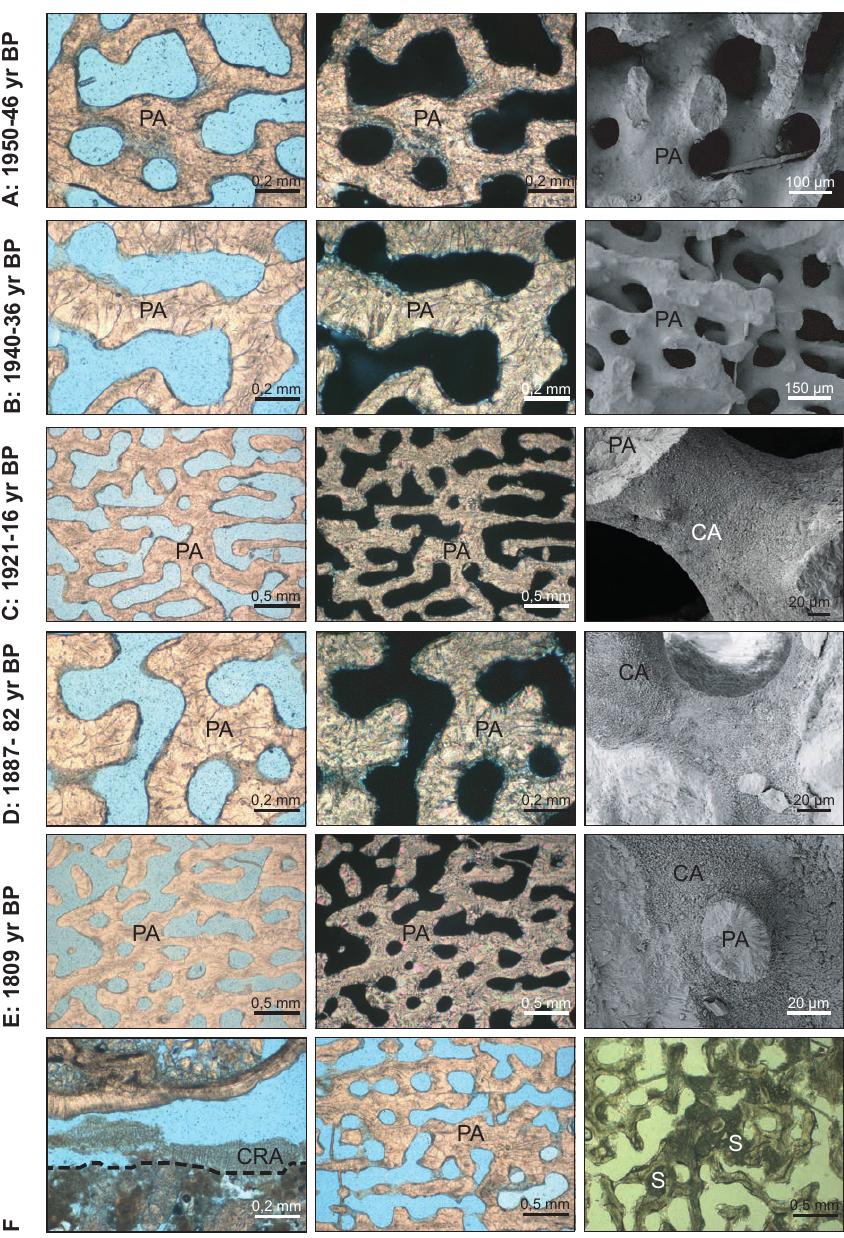
Figure 3. Thin-section and SEM images of primary coral aragonite (PA) and aragonite cement (AC) in cores Totor and Cabri. (a) and (b) : excellent preservation of the primary coral aragonite in core section 4A and 4B in Totor. Trace amounts of aragonite cements occur as isolated patches in core sections 6 (c) , 7 (d) and 11 (e) of Totor. (f) Left: a prominent growth break (stippled line) in core section 12 of Totor is encrusted by coralline red algae (CRA). (f) Middle: the section above the growth break shows well preserved primary coral aragonite. (f) Right: the pristine coral skeleton of core Cabri contains locally aragonitic sediment (S) partially filling growth-framework pores. (a–f) : thin section photographs are shown in plane- (left) and cross-polarized light (middle). (a–e) : scanning electron microscopy images